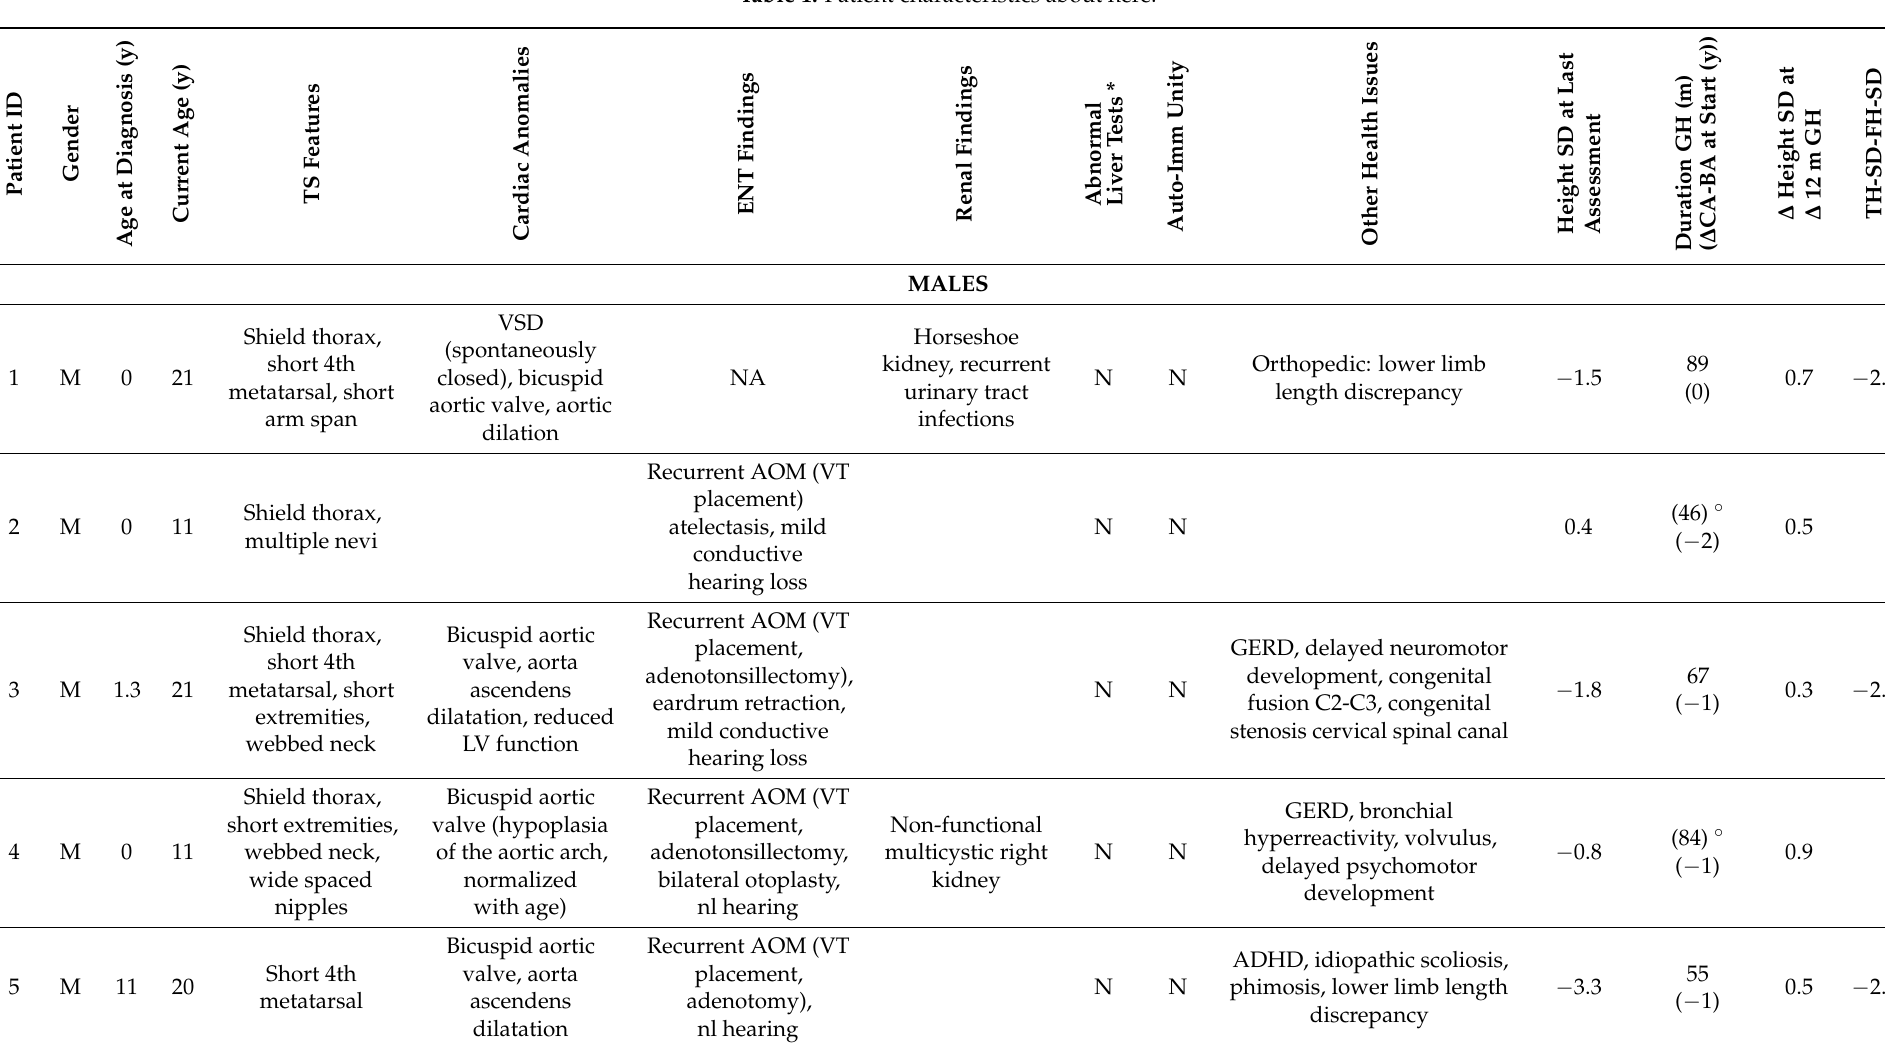
Table 1. Patient characteristics about